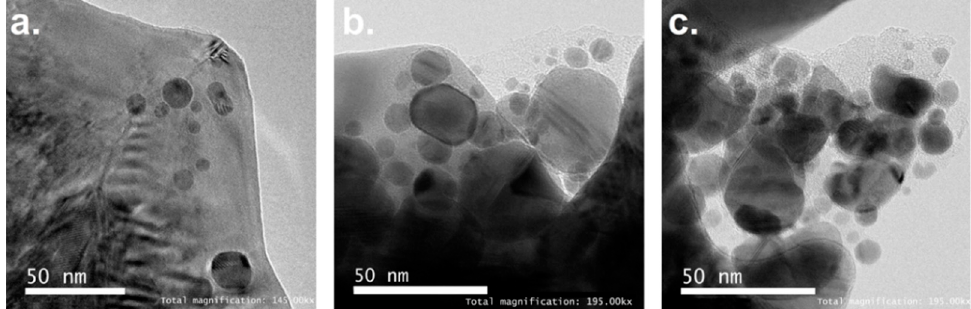
Figure 3. TEM images of (a) PEEK/Ag0.04, (b) PEEK/Ag0.08 and (c) PEEK/Ag0.12. The samples were coated with two layers of AgNPs.